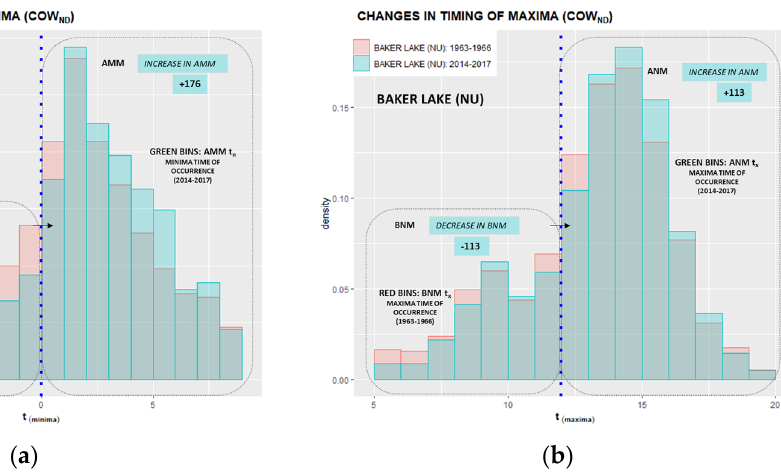
Figure A22. Cont